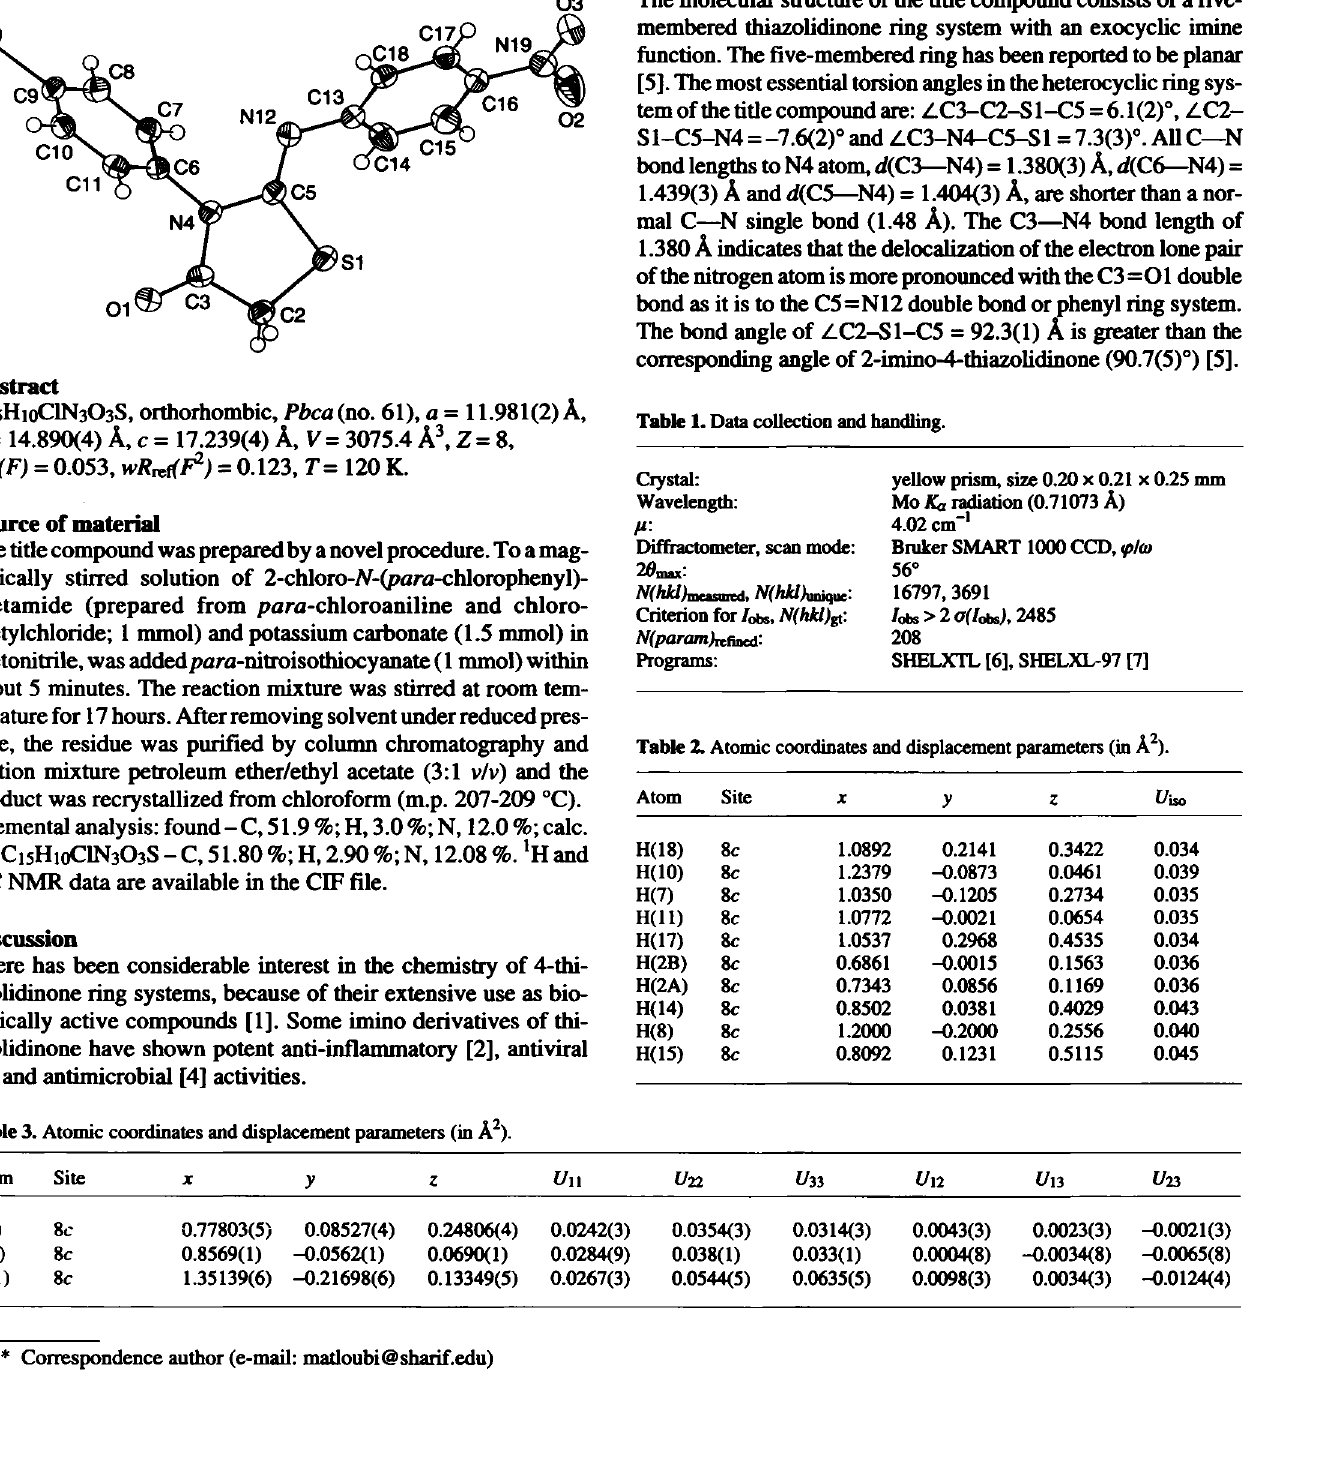
Table 1. Data collection and handling.